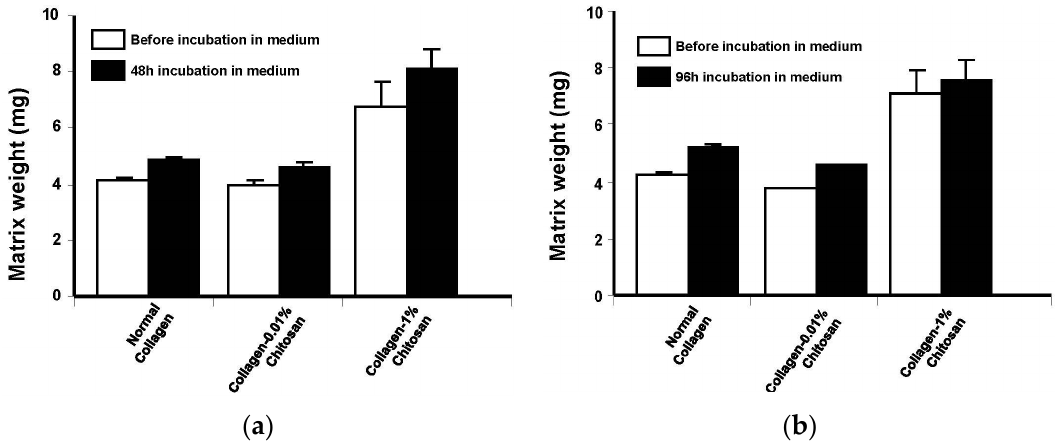
Figure 6. Weight lost of chitosan-coated collagen membrane following incubation with cell culture medium. Following the design of the different membranes, these were weighted at time zero. They were then immersed in culture medium and maintained at 37 °C for 48 and 96 h. At the end of each incubation period, membrane were washed with sterile water and dried for 4 days. The weight of each membrane was registered and compared to the initial one; n = 4. ( a ) Membrane weights at 48 h; ( b ) Membrane weights at 96 h.